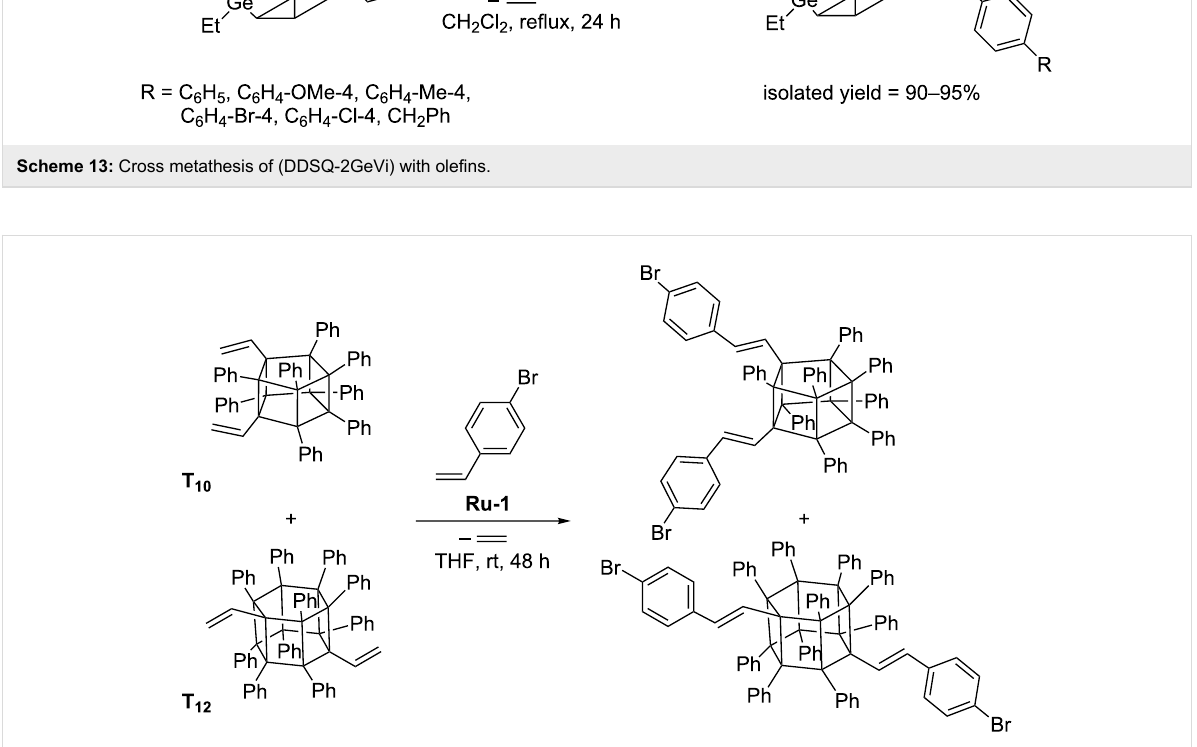
Scheme 14: CM of divinyl-substituted T 10 and T 12 with 4-bromostyrene (selected isomers are shown).